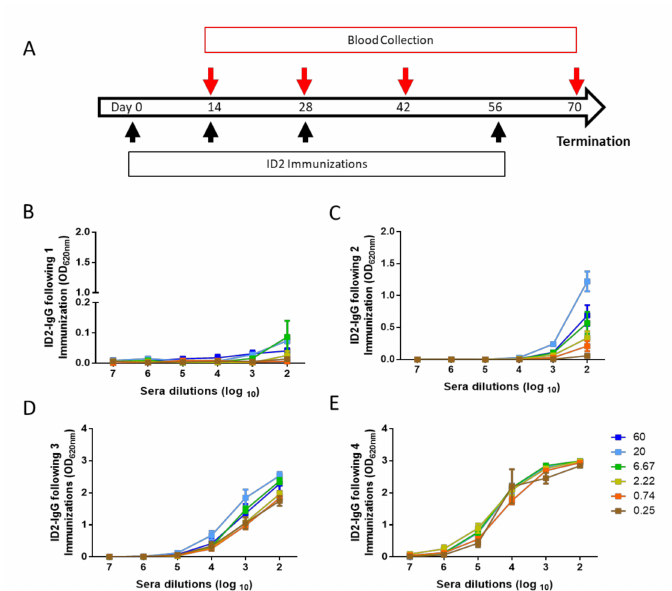
Figure 1. Kinetics and titer of ID2-specific IgG. Kinetics and titers of ID2-specific IgG induction over the course of ID2 + GLA-SE immunization using the vaccination scheme shown in ( A ). Throughout the immunization protocol, sera were collected two weeks post vaccination for each time point and analyzed for the induction of IgG against ID2 in an ELISA format. Sera were analyzed 2 weeks following ( B ) one immunization, ( C ) two immunizations, ( D ) three immunizations, and ( E ) the fourth and final immunization. n = 6 mice for each group, sera were evaluated for each mouse in triplicate and displayed as mean ±